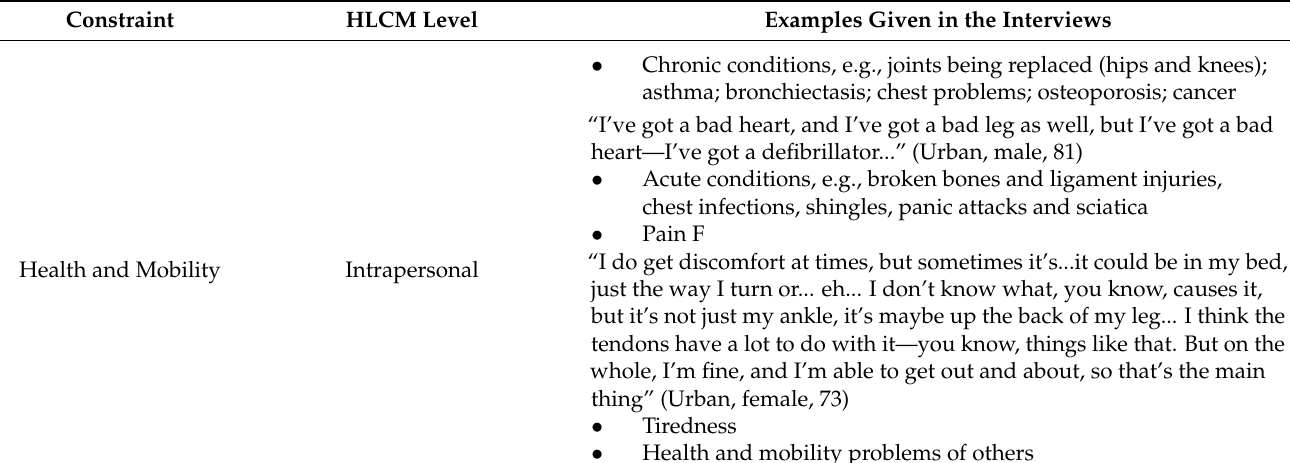
Table 2. Constraints and HLCM levels identified with illustrative